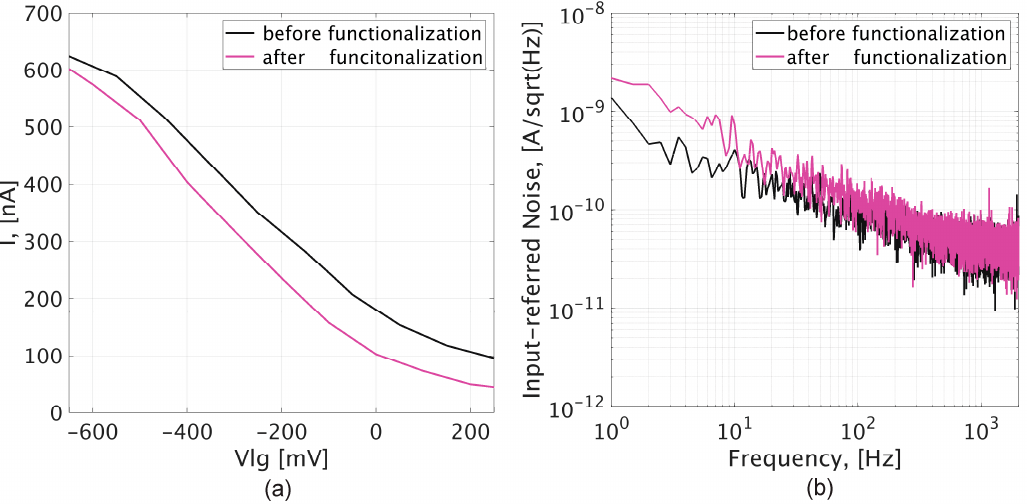
Figure 7. ( a ) Current − voltage characterization (I-Vlg curve) of a CNTFET before (green) and after (red) enzyme immobilization; ( b ) Input-referred power spectral density (PSD) of the corresponding CNTFET device, recorded in phosphate-buffered saline (10 mM PBS).